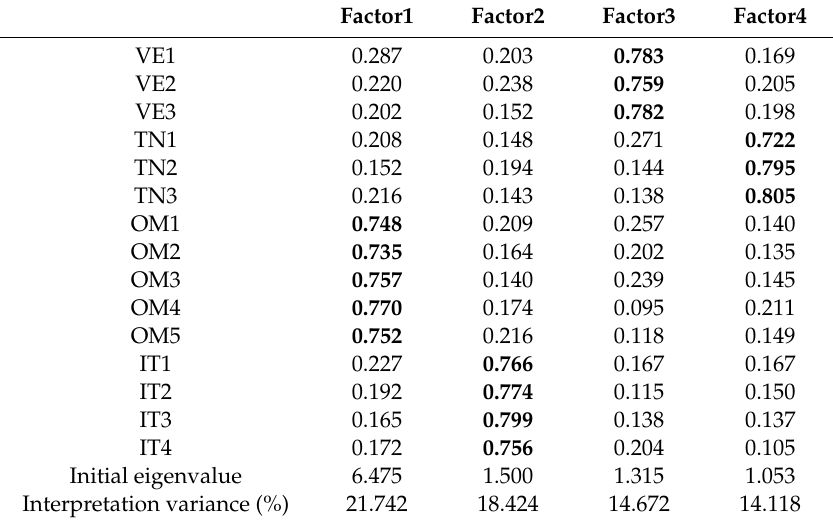
Table A4. Factor loadings after factors are